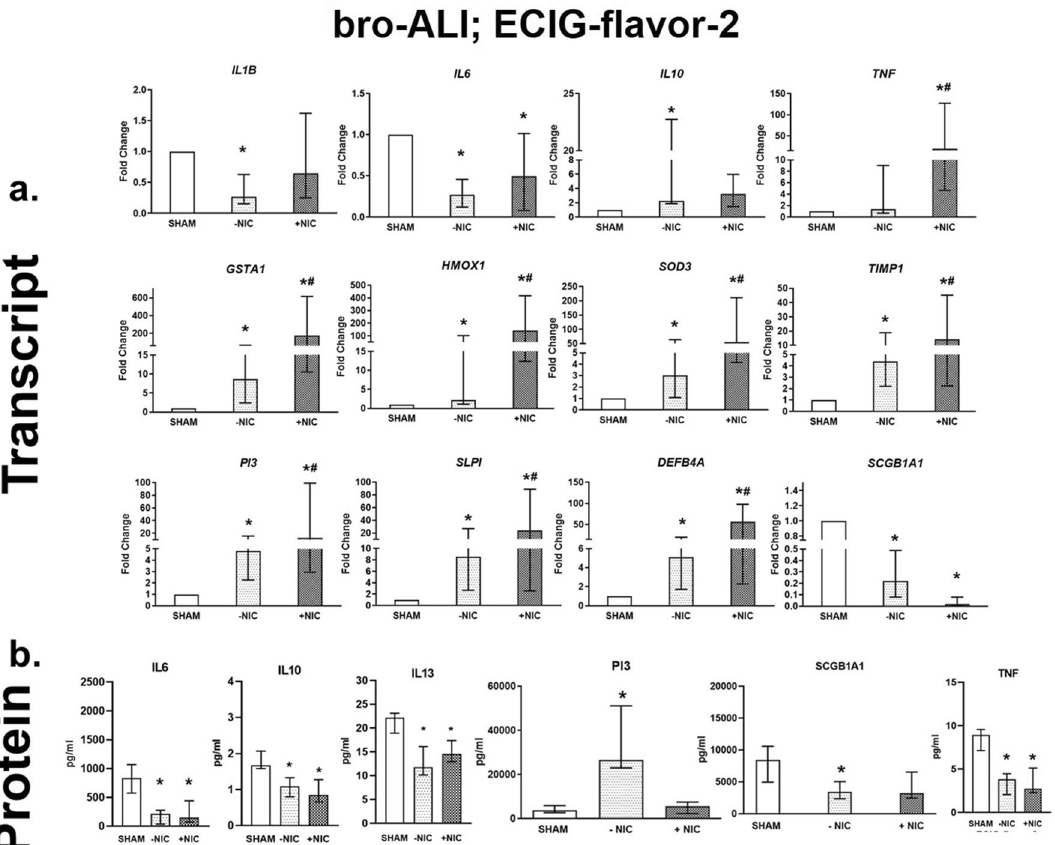
Figure 4. Transcript expression ( a ) and secreted protein levels ( b ) of significantly altered pro-inflammatory, oxidative stress, tissue injury/repair, alarm anti-proteases, and/ or anti-microbial defensin markers in the bronchial mucosa model cultured at air–liquid interface (bro-ALI) following exposure to aerosolized non- nicotinized (−NIC) and nicotinized (+NIC) electronic cigarette liquid flavor 2 (ECIG-flavor-2). Actin beta ( ACTB ) was used as the reference gene. Fold changes for transcript expression were calculated relative to the corresponding sham *: significantly different from sham; #: significantly different from −NIC ( p < 0.05, Friedman followed by Wilcoxon test). DEFB4A : defensin beta 4A, GSTA1 : glutathione S-transferase alpha 1, HMOX1 : heme oxygenase 1, IL: interleukin, PI3 : peptidase inhibitor 3, SCGB1A1 : secretoglobin family